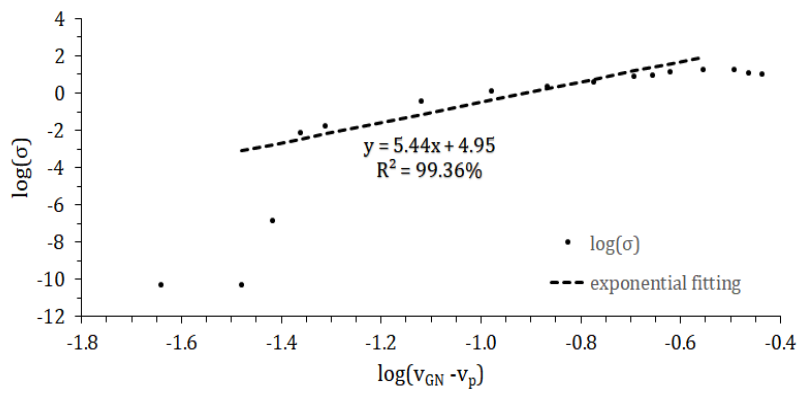
Figure 5. Linear fitting of silicone/graphene nanoplatelets composite conductivity logarithm versus logarithm of graphene volumetric fraction. Points under 8 vol% and above 25 vol% content were not included due to conductivity plateau.